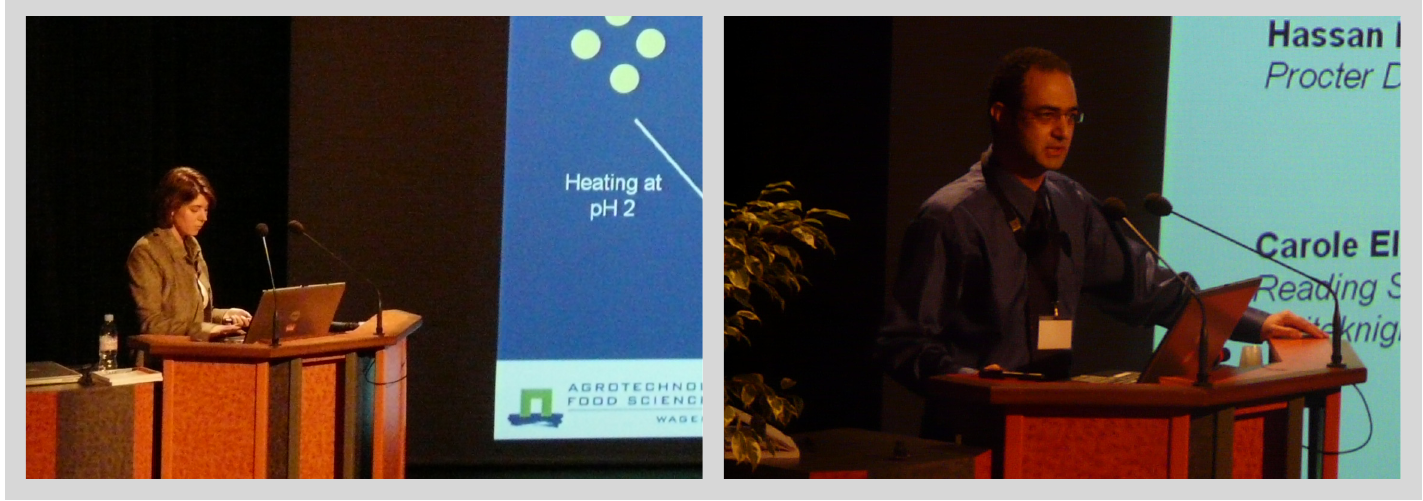
Figure 1 (left): Cynthia Akkermans giving a talk on protein fibrillation. Figure 2: Firoozmand